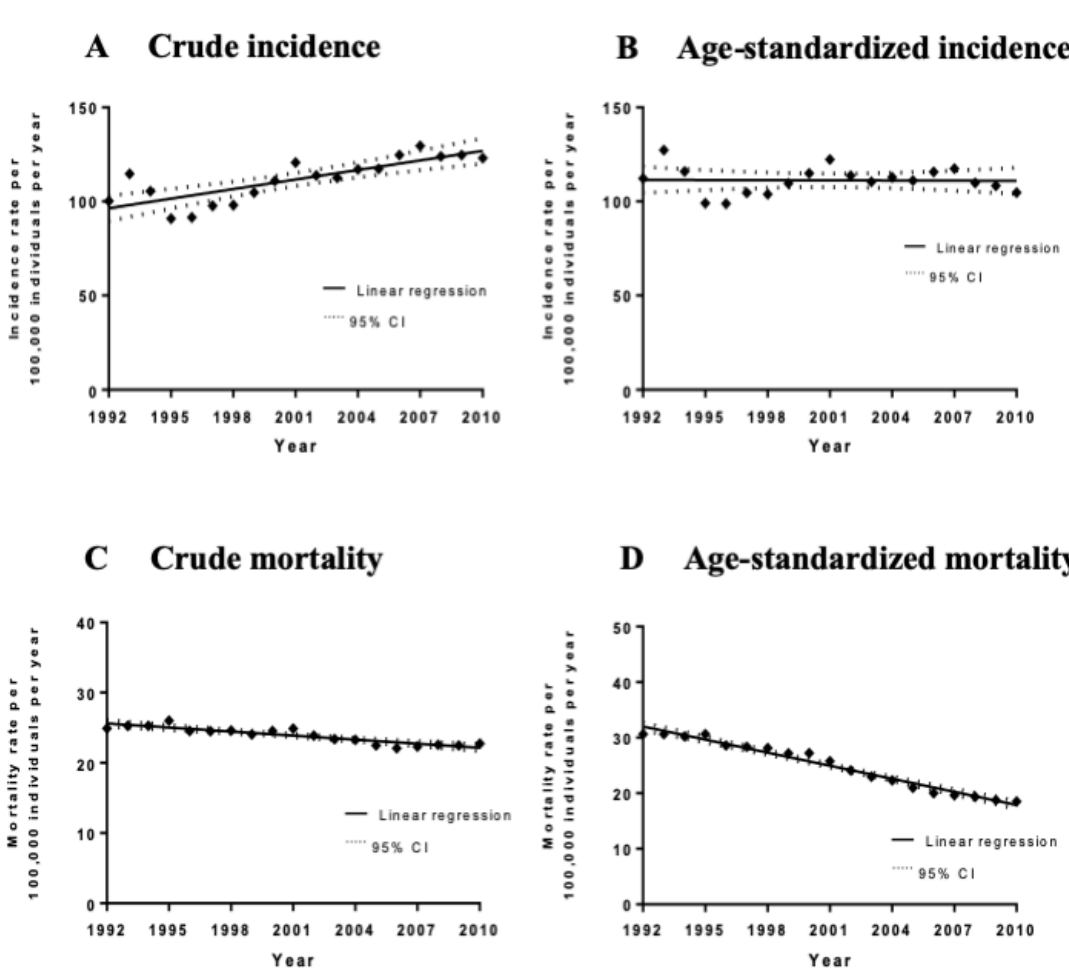
Figure 1. Incidence and mortality rates (per 100,000 individuals per year) of all cases and deaths between 1992 and 2010 with the line of best fit, and linear regression analysis of the incidence rate over time. ( A ) Crude incidence trends. The slope of the line is 1.67 ± 0.303 cases per 100,000 males per year, p < 0.0001. ( B ) Age-standardized incidence trends. The slope of the line is − 0.028 ± 0.312 cases per 100,000 males per year, p = 0.93. ( C ) Crude mortality trends. The slope of the line is − 0.19 ± 0.022 cases per 100,000 males per year, p < 0.0001. ( D ) Age-standardized mortality trends. The slope of the line is − 0.79 ± 0.032 cases per 100,000 males per year, p < 0.0001.